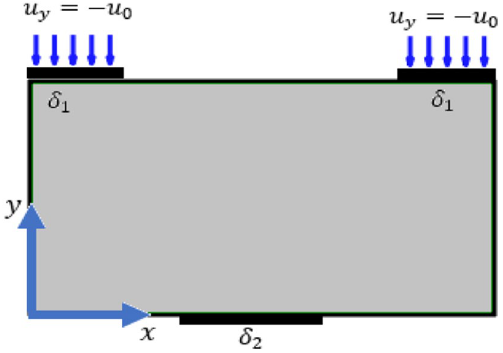
Figure 2. Second boundary value